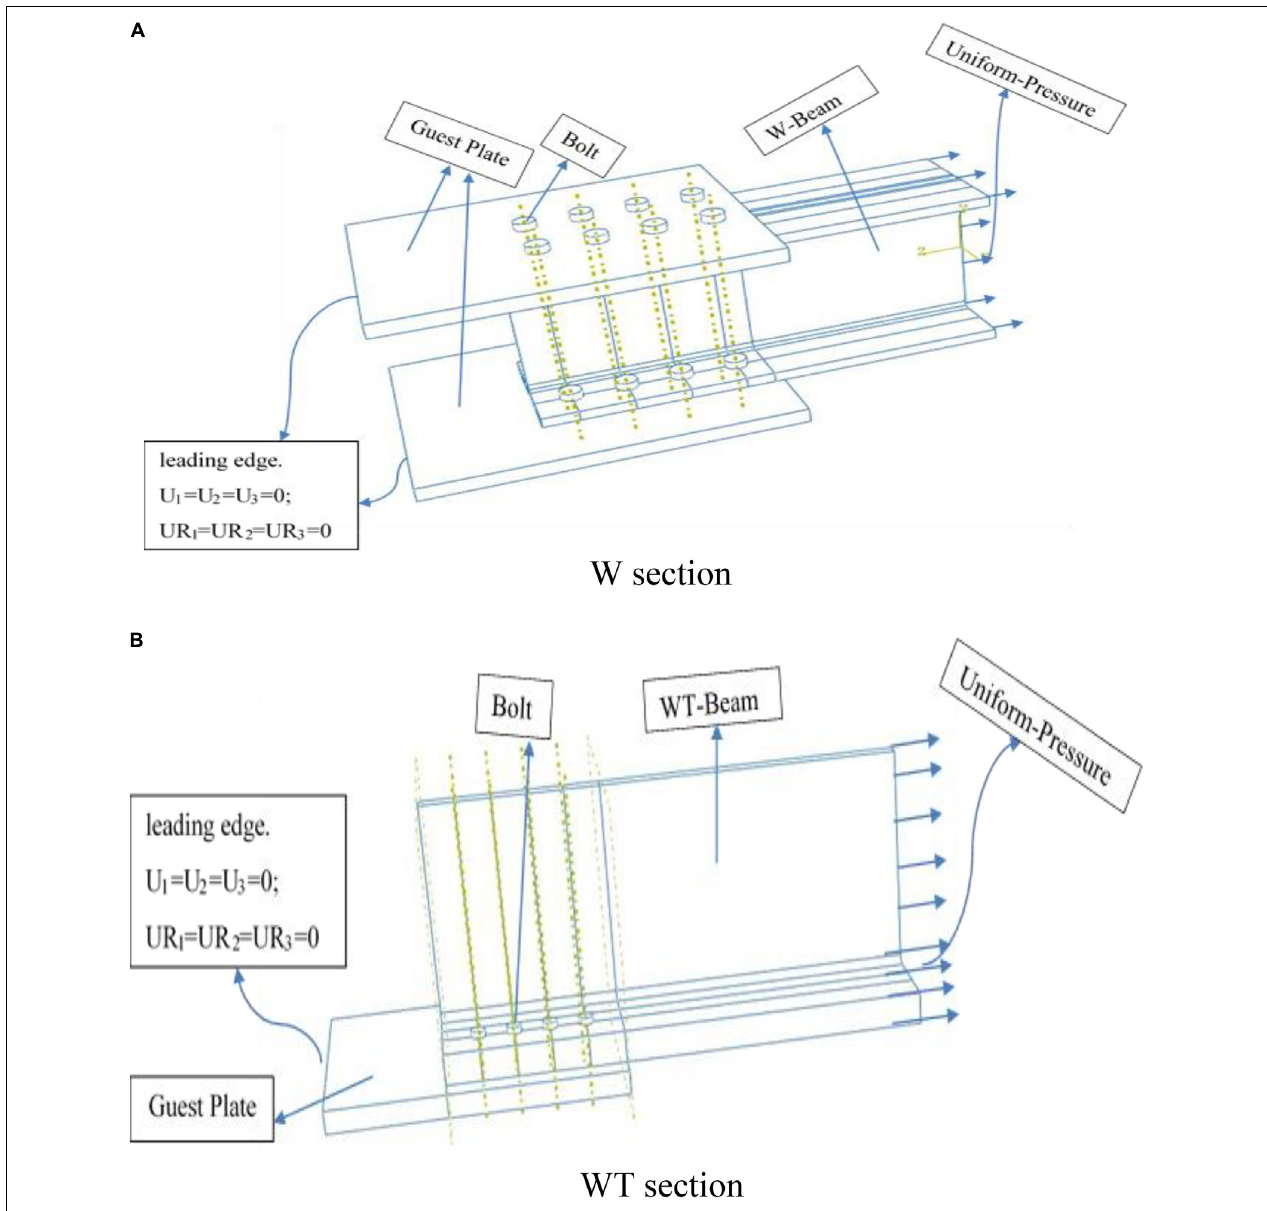
FIGURE 1 | Typical FE model of bolted. (A) W section and (B) WT